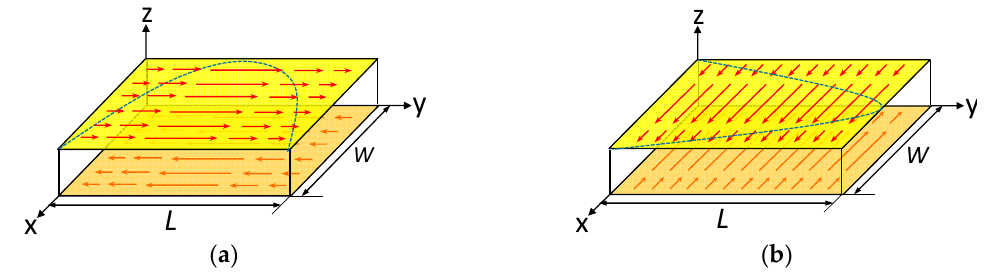
Figure 2. Current distribution of different antenna radiation modes. ( a ) current density of the TM 010 mode; ( b ) current density of the TM 001